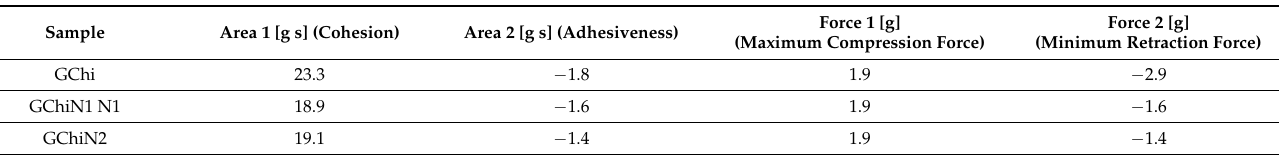
Table 1. Texture properties of chicha hydrogels (GChi) and chicha hydrogel with 0.01 g mL −